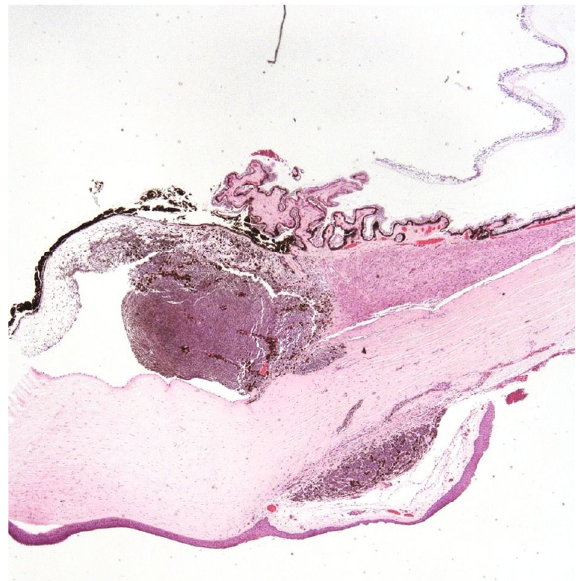
Figure 3: Microscopical examination demonstrating iris melanoma with extension in the anterior angle, in fi ltration of the trabecular meshwork and extrascleral extension (black arrow) (hematoxylin and eosin, original magni fi cation, 40 ×